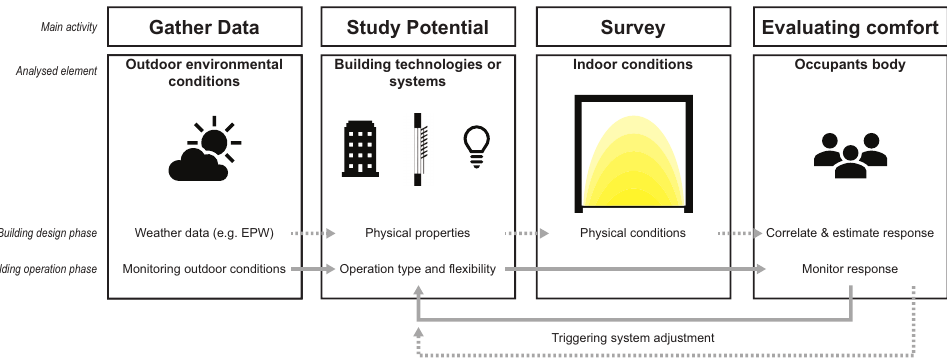
Figure 3. Description of the new concept for building components operation, shifting from monitoring the indoor physical conditions into monitoring the hosted occupant’s body’s physiological